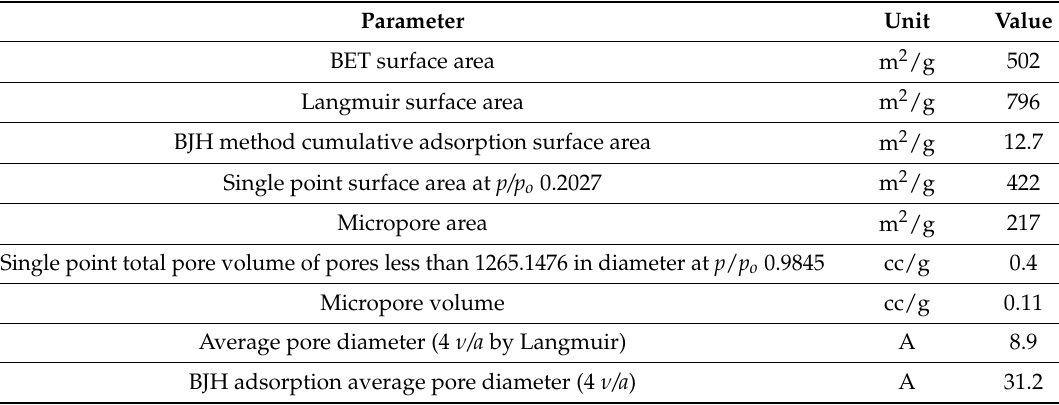
Table 1. Characteristics of the cross-linked magnetic chitosan/activated biochar (CMCAB).